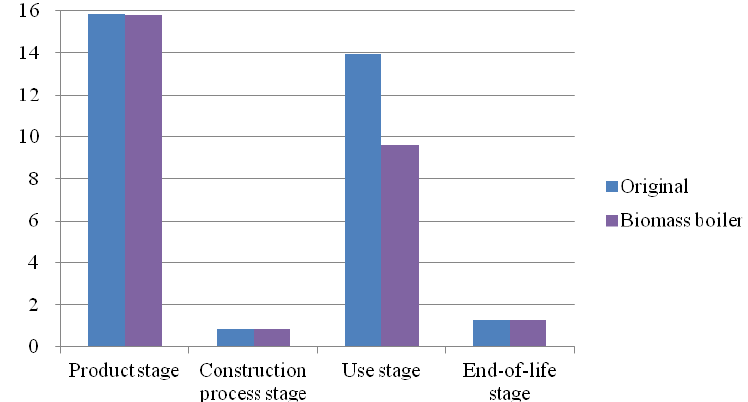
Table 11. Numerical comparison of the global warming potential impact (in kg CO -Eq/m 2 year) in the building analyzed according to the biomass boiler improvement. 2 Global Warming Potential (kg CO -Eq/m 2 year *) 2 Life cycle stage Original Biomass boiler Product stage 15.85 15.83 Construction process stage 0.82 Use stage 1.29 Figure 8. Graphical comparison of the global warming potential